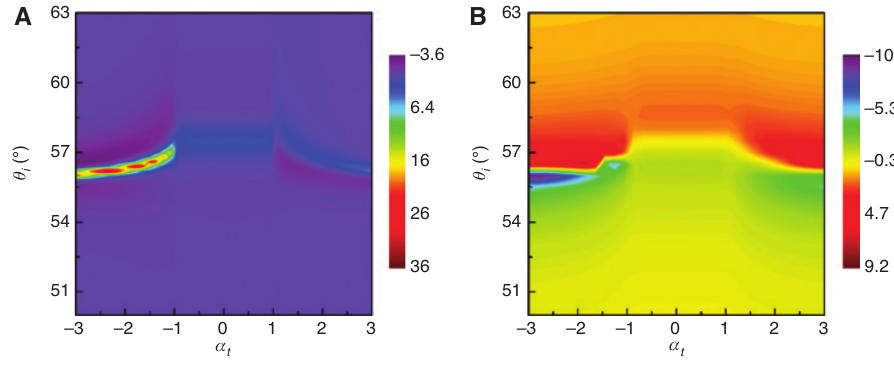
and the incident angle on the photonic spin Hall shifts. t ⟩ and ⟨ Δ y ⟩) as a function of the tilt α + +